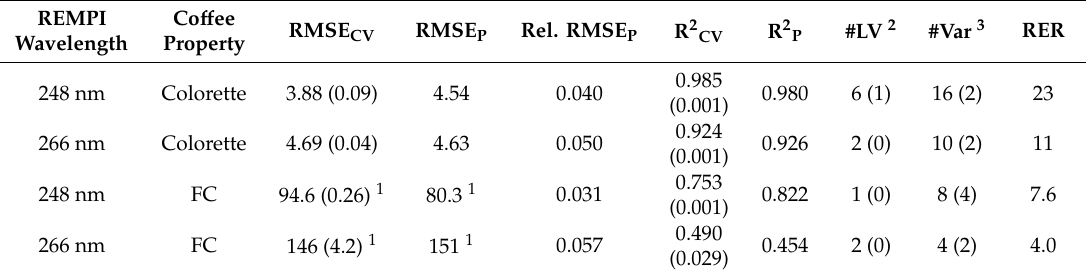
Table 1. Figures of merit: Model properties and precision in prediction. Numbers in brackets refer to standard deviation of results from 100 repetitions of competitive adaptive reweighted sampling